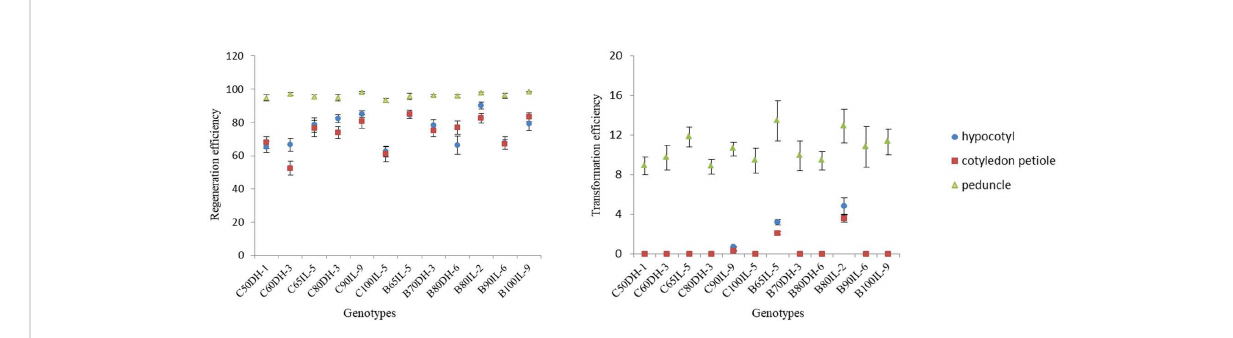
FIGURE 2 Effect of genotypes on the shoot regeneration and transformation ef fi ciency of different explants. The regeneration and transformation rate were calculated as the percentage of the explants regenerated shoots and positive regenerated plants/total explants, respectively, for each